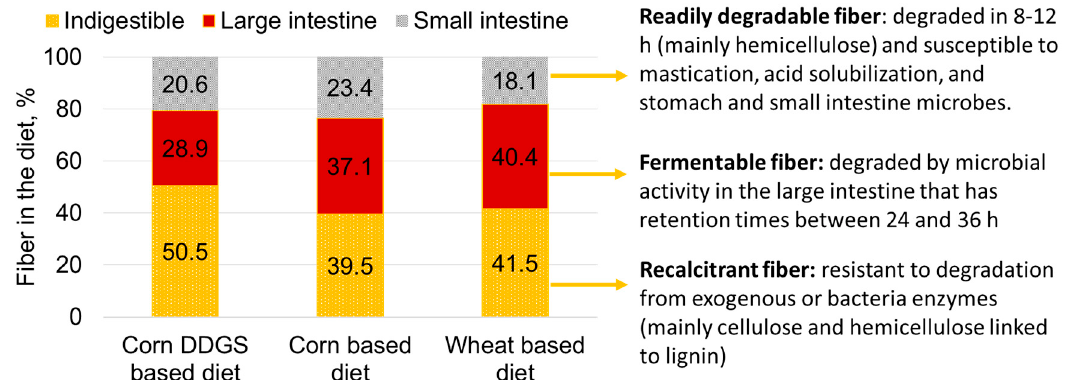
Figure 3. Total dietary fiber fractions degraded in the small intestine and large intestine, and the indigestible portion of diets with corn distillers dried grains with solubles (DDGS), and corn- and wheat-based diets (adapted from [319,320,321]).